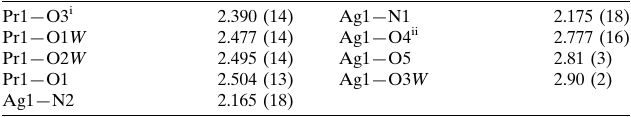
Selected bond lengths (A˚ ).